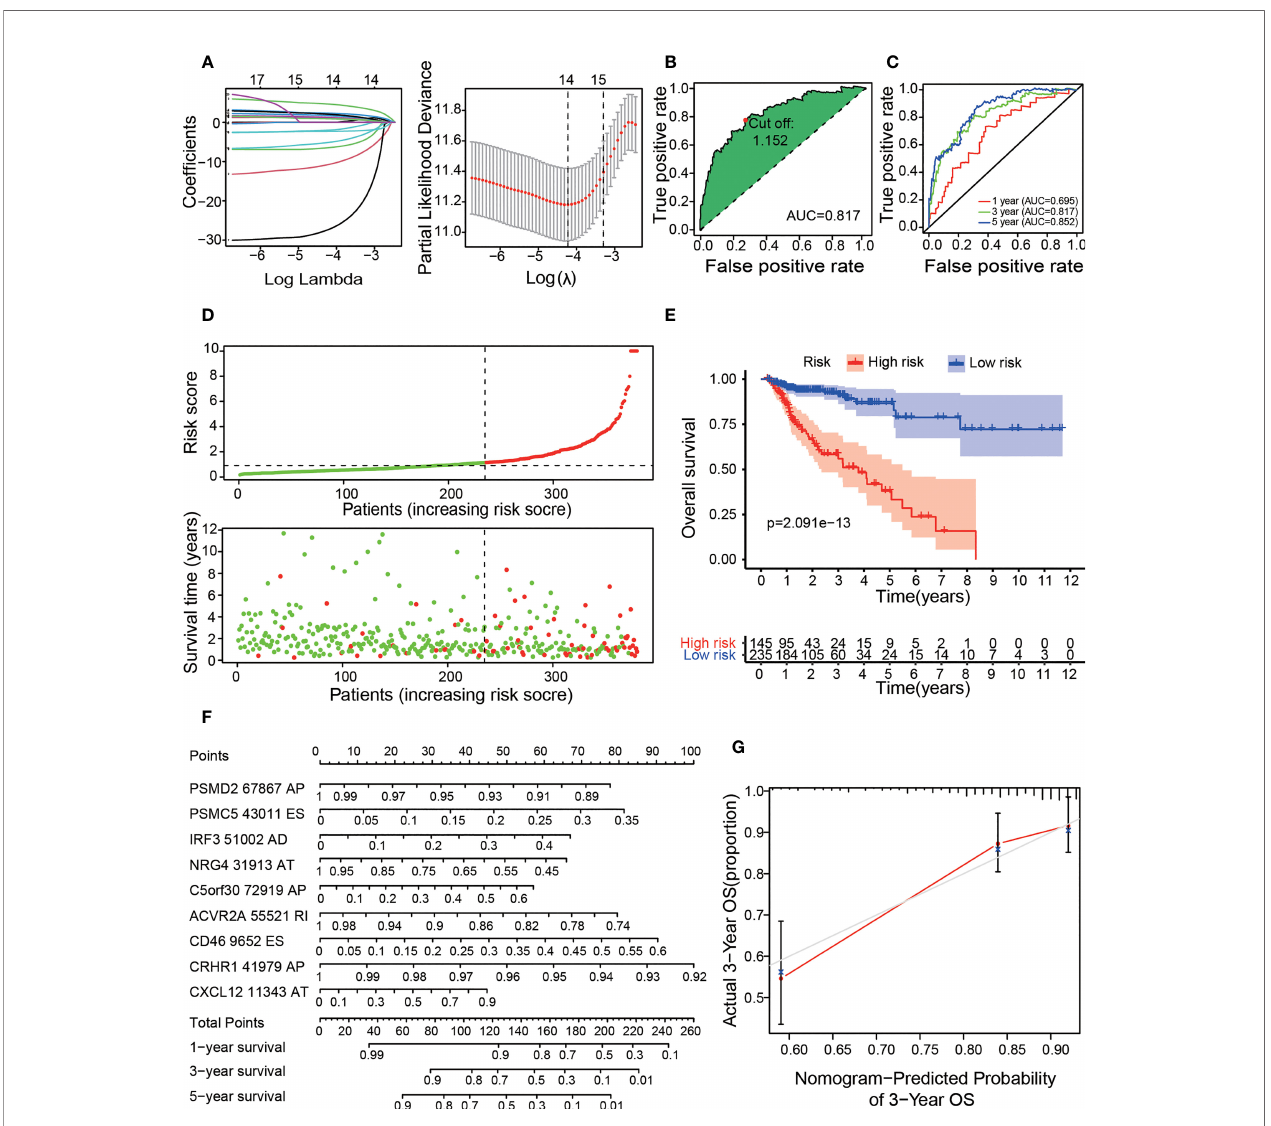
FIGURE 3 | Construction of the prognostic risk model with OS-ASEs. (A) LASSO Cox analysis. The right sub fi gure shows the process by which the log lambda value, which we selected as the minimum cross-validation error point, was calculated. The OS-ASEs with nonzero coef fi cients corresponding to the selected log lambda value were obtained for risk model construction in the left sub fi gure. (B) The ROC curve with the maximum in fl ection point for the optimal prognostic model. (C) The 1-, 3-, and 5-year ROC plots for the prognostic model. (D) The risk plot between the high- and low-risk groups. (E) Kaplan – Meier curve of OS outcomes for patients. The lighter blue and red regions represent the 95% CI areas of the prognosis curve. (F) Nomogram for predicting OS probabilities. The points achieved for each risk factor were summed on the total point axis, and the total points correspond to the OS probability of patients. (G) Calibration curve for evaluating the accuracy of the OS nomogram with 3-year OS data from the TCGA